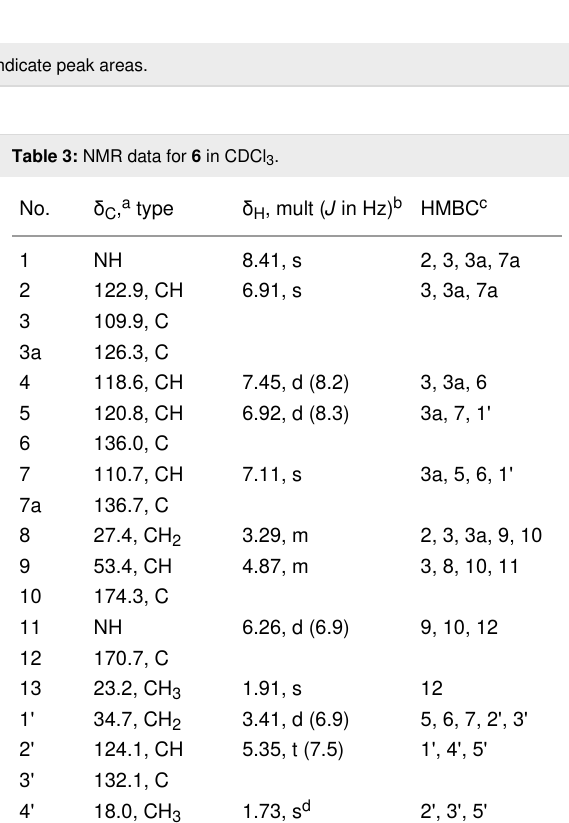
Figure 4: Chiral phase HPLC analysis of methyl ester 4' . Italicized numbers indicate peak areas.